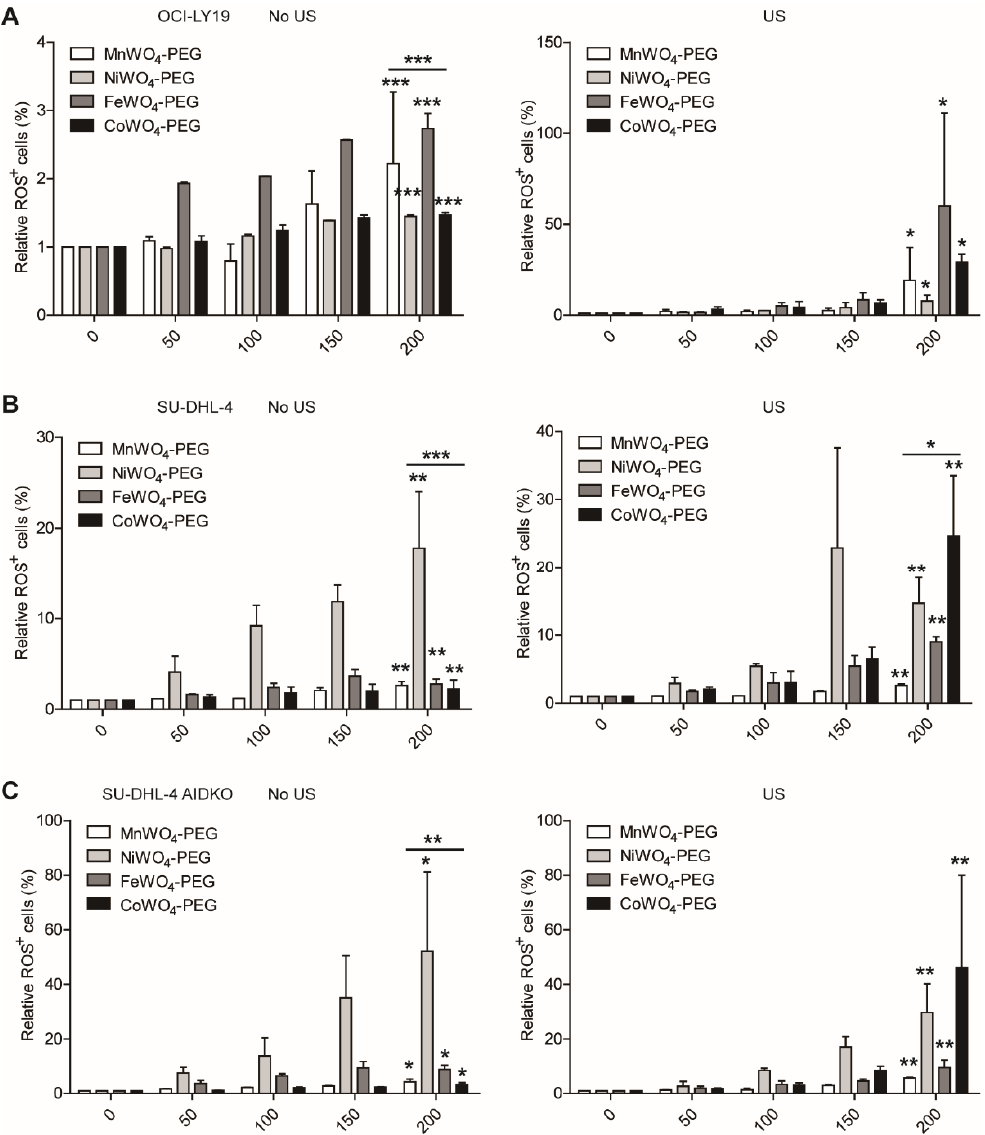
Figure 8. US-triggered toxicity of MWO 4 -PEG NPs. The relative ROS + generation of human OCI- LY19 ( A ), SU-DHL-4 ( B ), and AIDKO SU-DHL-4 ( C ) cells treated by increasing concentration (0, 50, 100, 150, 200 μ g/mL) of four MWO 4 -PEG NPs with (left figure) or without (right figure) US irradiation. The ROS was used to stain the NPs treated DLBCL cells to indicate ROS generation. The percentage of ROS + cells was detected by flow cytometry. The data shown are representative of 3 independent experiments. Data are represented as mean ± SD. *, ** and *** represent p < 0.05, p < 0.01 and p < 0.001, respectively.